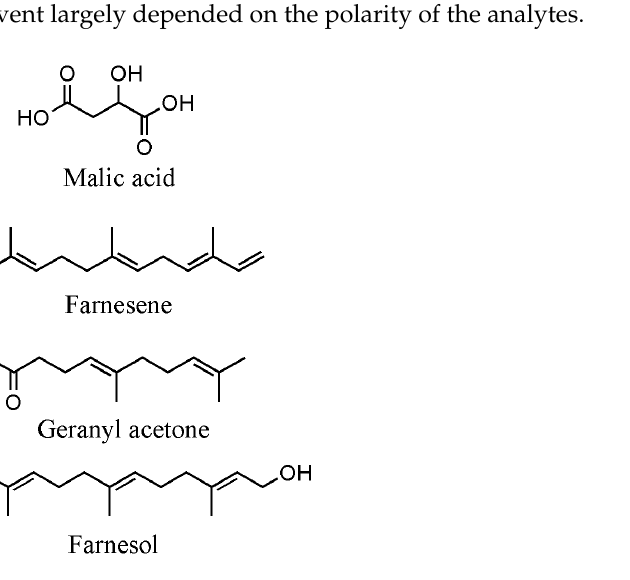
Figure 3. Main compounds responsible for the taste and flavor of apples.